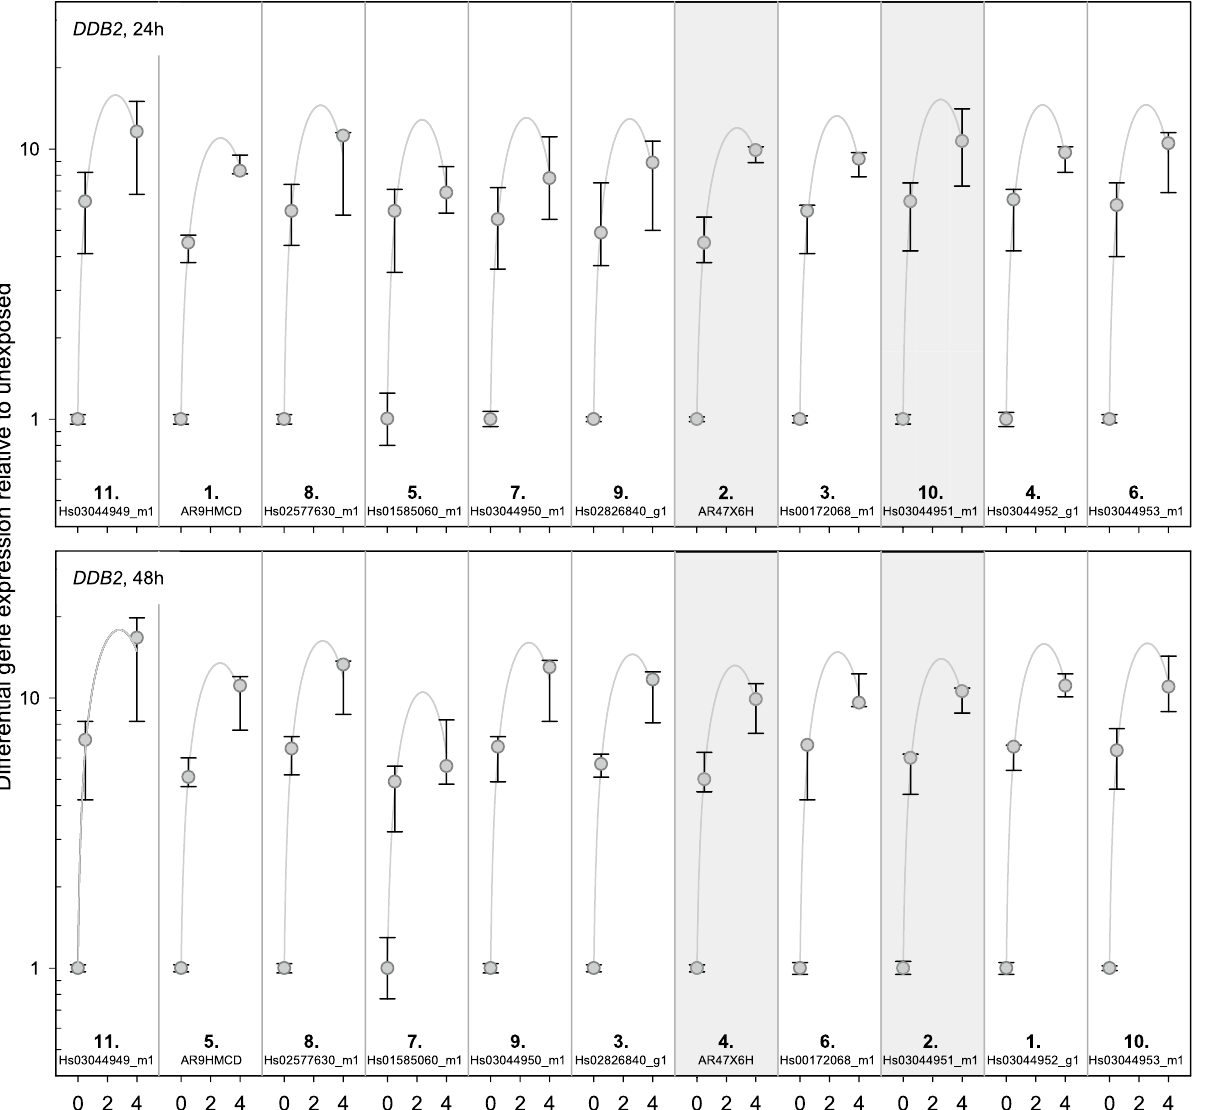
Figure 5. Inter-individual variability of DDB2 TaqMan assays. Plotted is the differential gene expression relative to unexposed of DDB2 for each assay after 24 h (upper panel) and 48 h (lower panel). The symbol represents the median, and the lower and upper whiskers represent the minimum and maximum fold change, respectively. Additionally plotted is the 2nd order regression line for each TaqMan assay. After summing up the standard deviations of radiation dose, ranks were assigned. 1st rank is the lowest inter-individual variability, 11th rank is the highest. The two assays highlighted in gray are those most suitable for biodosimetry as identified in Fig. 4 using other criteria (baseline, dose dependency, time persistency). Assay labels starting with the two capital letters “AR” can be found after creating an account at Thermo Fisher web site, entering the “Reorder Custom Assays” section with the implemented search function in the “Custom TaqMan Assay Design